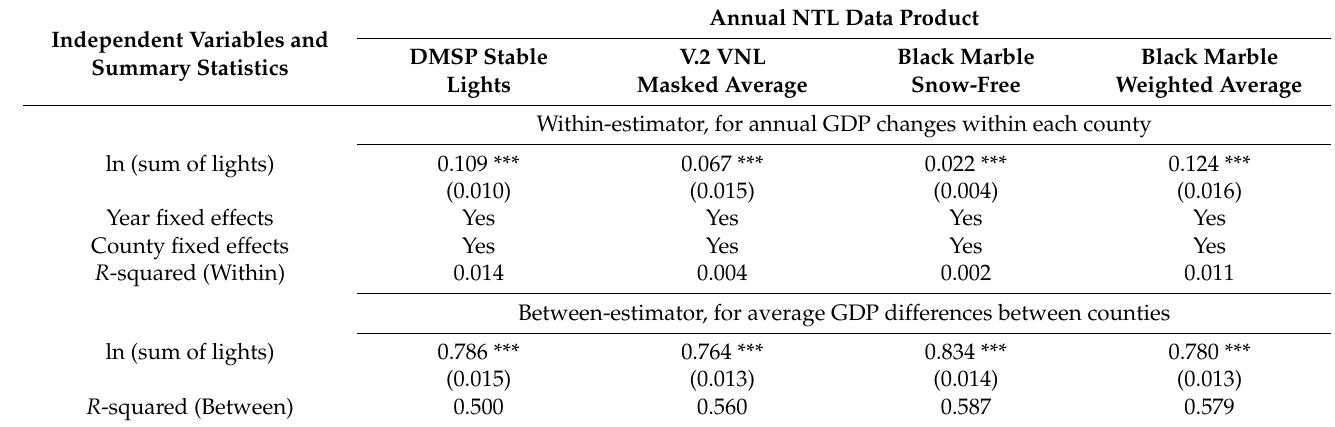
Table 3. Relationships between multi-source NTL and county-level GDP: within and between- estimator